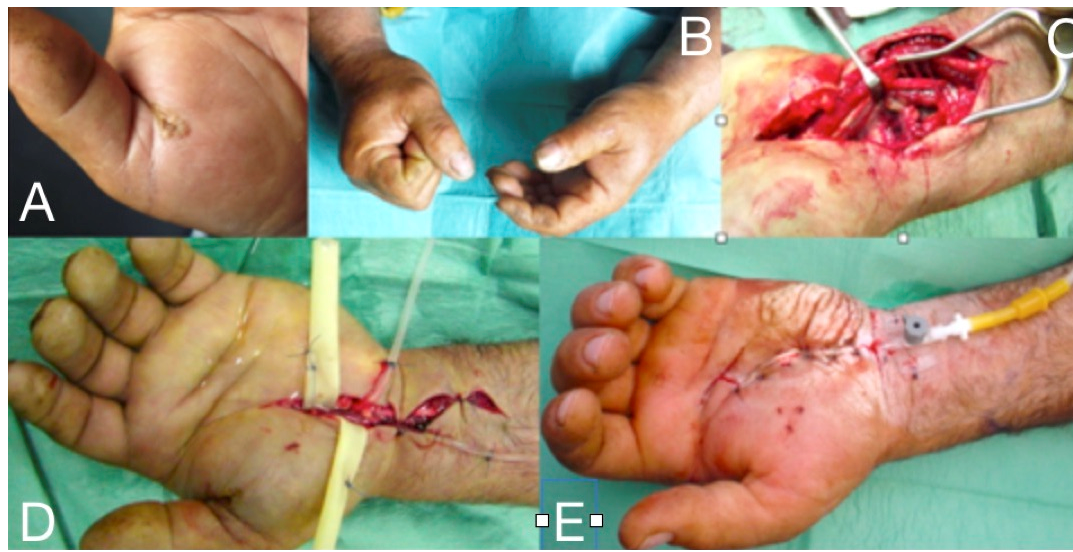
Figure 7. Thenar space infection due to penetrating wound in the palmar surface ( A ). Infection is extended to distal forearm ( B ). Thenar space, carpal tunnel and Parona’s space were incised, drained and thoroughly irrigated while median nerve is recognized and protected ( C , D ).